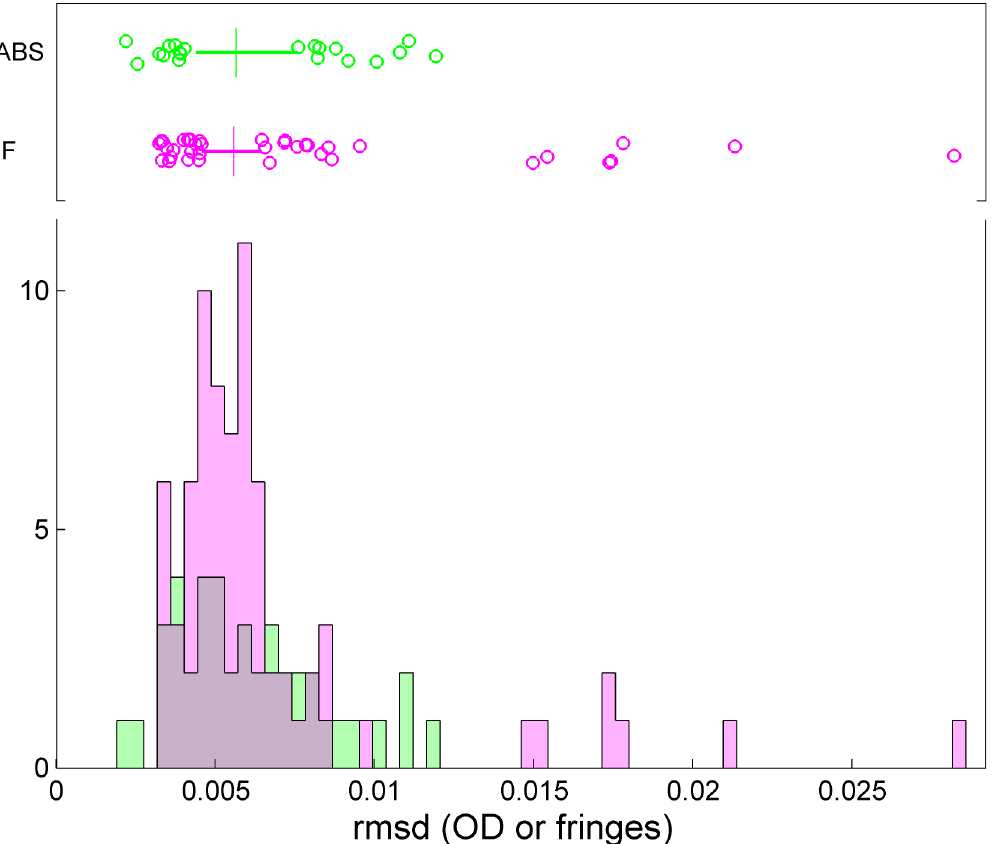
Fig 8. Root-mean-square deviation of the best-fit c ( s ) model of the BSA sedimentation experiment when scanned with the absorbance system (green) and the interference system (magenta). The box-and-whisker plot indicates the central 50% of the data as solid line and draws the smaller and larger 25% percentiles as individual circles. The median is displayed as a vertical